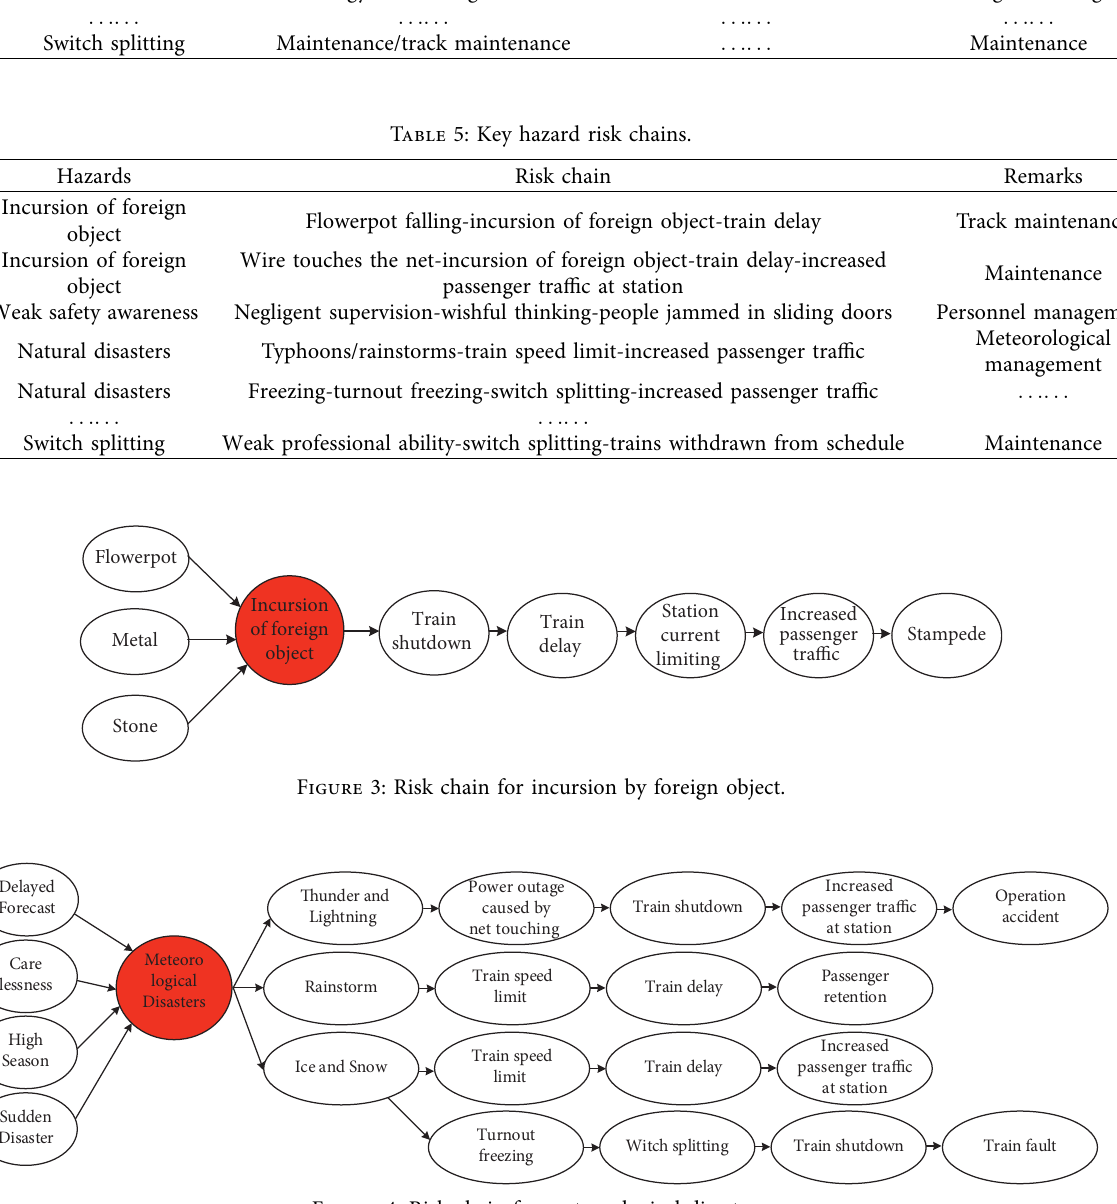
Figure 4: Risk chain for meteorological